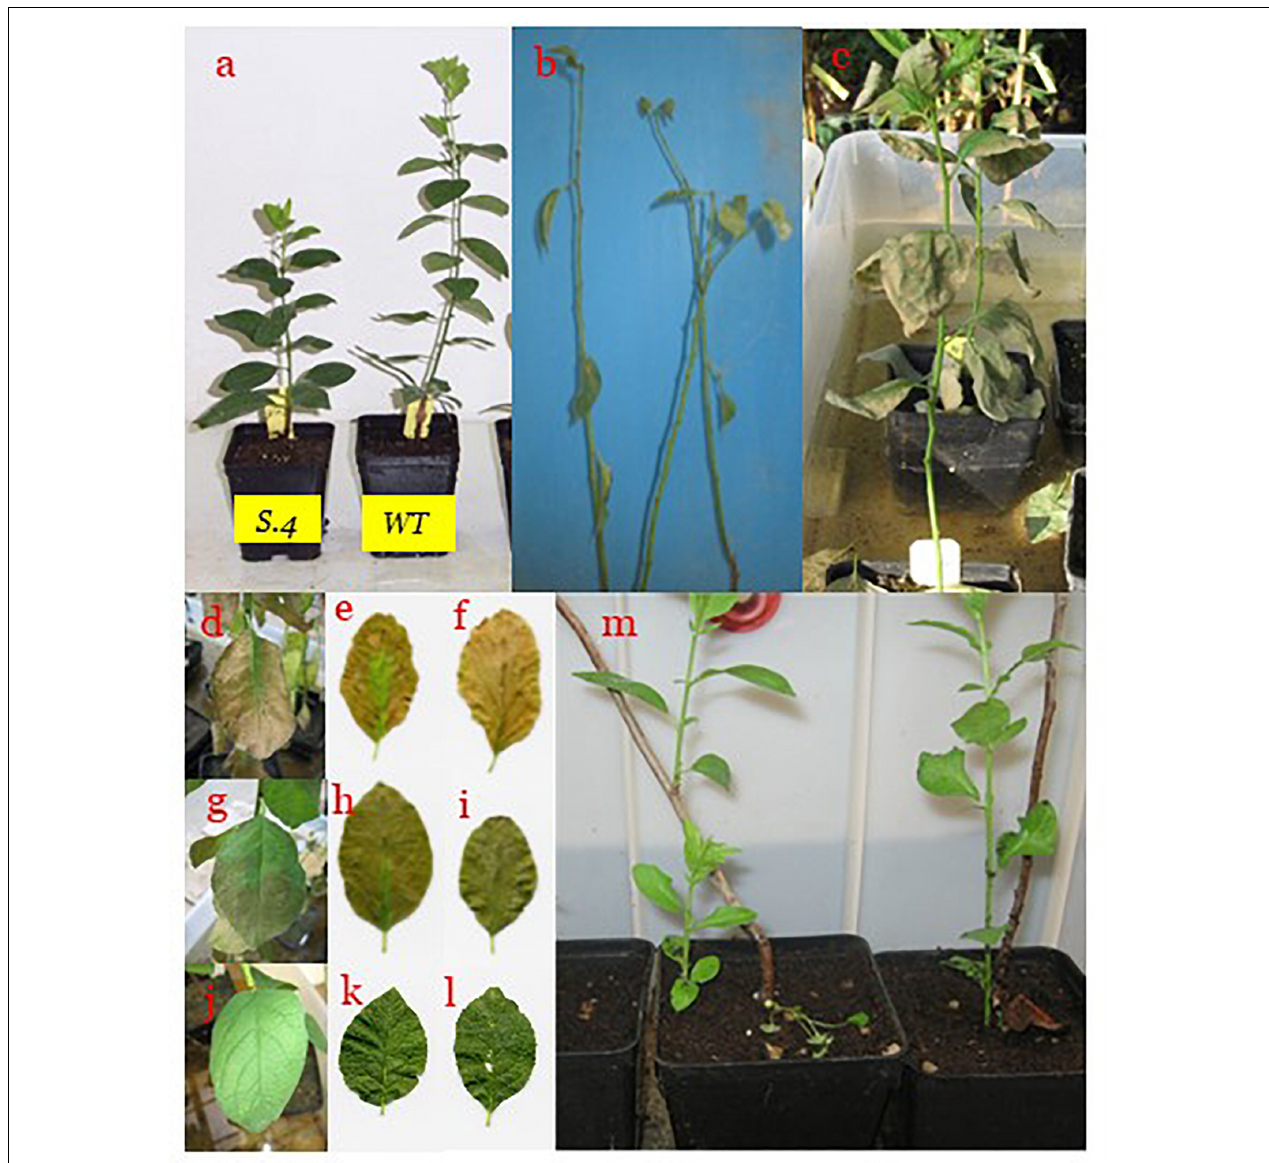
FIGURE 2 | Plant behavior during treatments. Re-growth of apical bud (A) in S.4 and WT plants exposed to the constant photoperiod (CP) since the mid-July under normoxic conditions. S.1 -plants behaviors at the end of flooding period (28 days) exposed to CP (B) and to NP (C) . State of leaf detected during flooding (14th, 21st, 28th day) in S.1 (D–F) , WT (G–I), and S.4 (J–L), respectively. S.4 -stressed plants exposed to CP showed loss of basal leaves, development of sprouts and suckers from lateral buds and root systems (M),